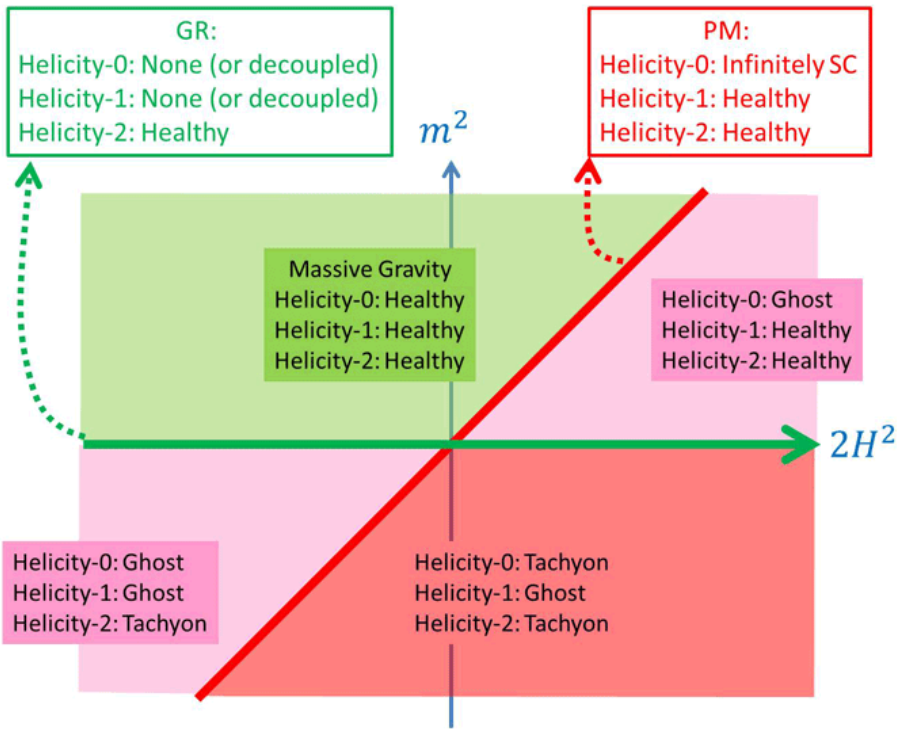
Figure 4: Degrees of freedom for massive gravity on a maximally symmetric reference metric. The only theoretically allowed regions are the upper left green region and the line 𝑚 = 0 corresponding to